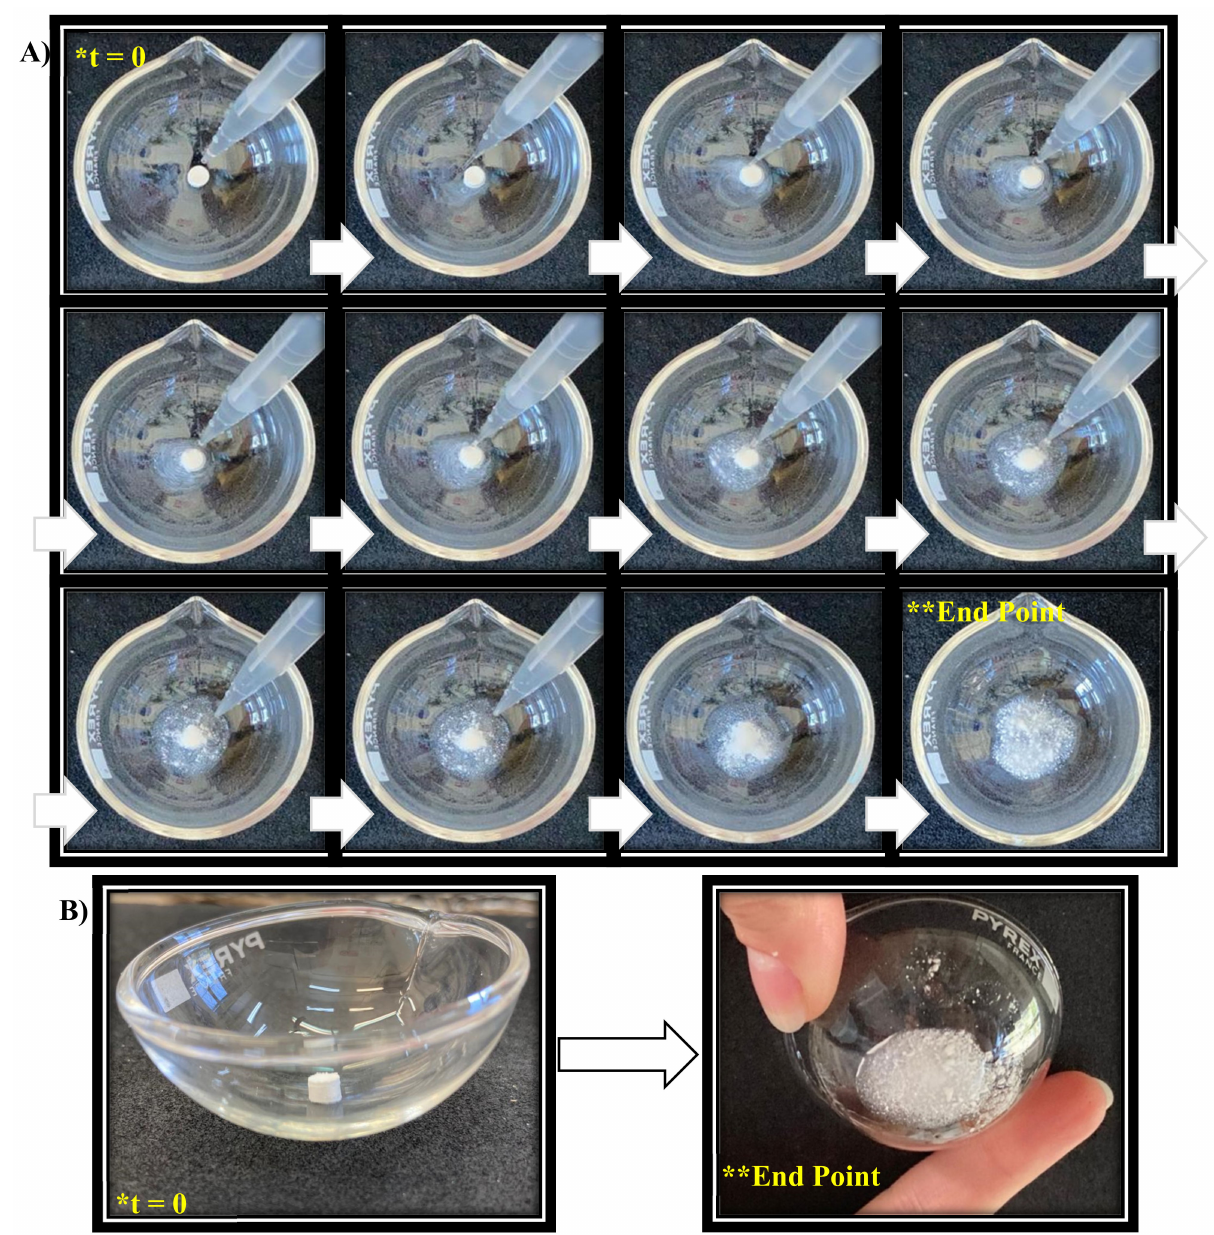
Figure 10. In vitro disintegration visual test: ( A ) sequence of photographs; ( B ) highlights of the starting and end points (for a more complete result please check the videos in the Supplementary